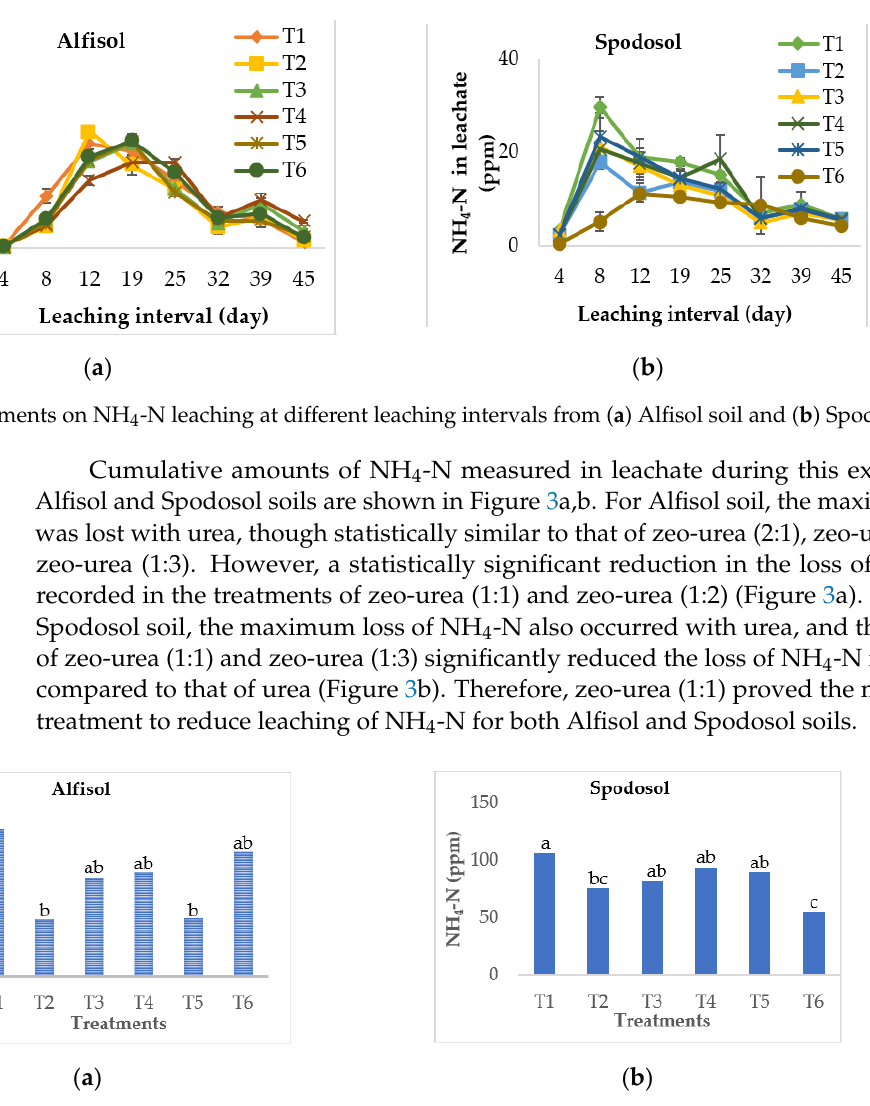
Figure 3. Effect of treatments on cumulative losses of NH 4 ‐ N from ( a ) Alfisol soil and ( b ) Spodosol soil. Means with different letters indicate significant differences among treatments by Tukey’s test at p ≤ 0.05.